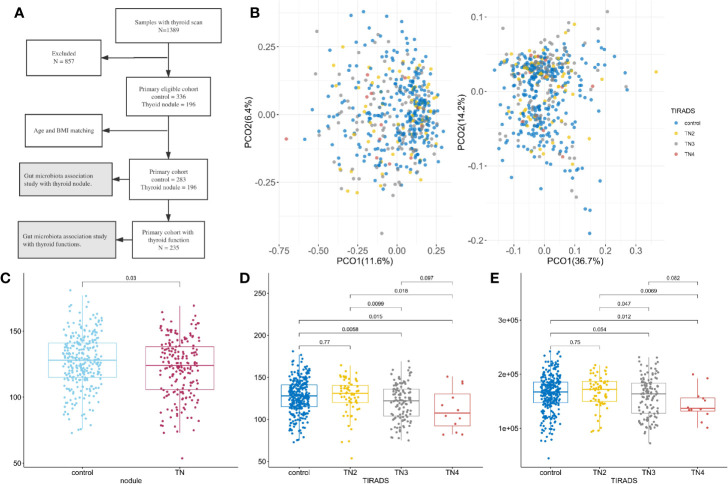
Microbiome composition and diversity. For all boxplots in this study, center is median, box is interquartile range (IQR), whisker is 1.5 × IQR. (A) Metagenomics Genome-Wide Association Study on the primary cohort; (B) Principal coordinate analysis with Spearman’s coefficient distance based on relative abundance of species (left panel) and pathways (right panel). Colored dots represent samples with TI-RADS grade, x-axis is PCO1, and y-axis is PCO2. Control (n = 283): no obvious nodules found in thyroid ultrasound. TN2 (n = 63): TI-RADS level 2. TN3 (n = 121): TI-RADS level 3. TN4 (n = 12): TI-RADS level 4a; (C–E) Boxplot showing distribution of microbial characteristics. Significance determined by single-sided Wilcoxon rank sum test. (C) Number of observed species (OBS) in control and TN; (D) OBS in TI-RADS; (E) Number of observed gene families in TI-RADS.